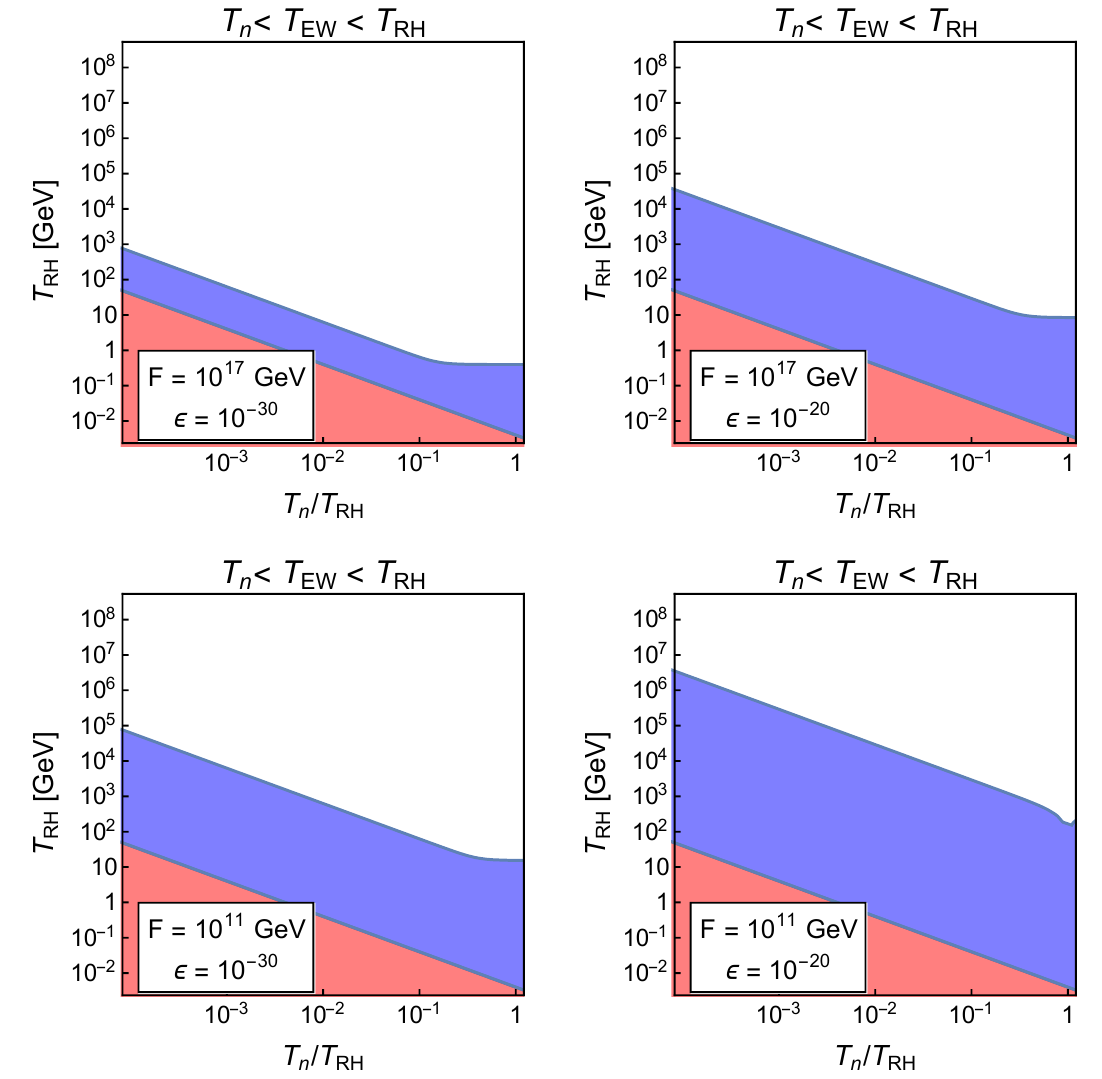
Figure 3. Regions in which the relative variation of the Higgs VEV of eq. (3.10) is larger than unity (blue) and therefore the solution of the hierarchy problem is spoiled and in which the nucleation or the reheating temperatures are smaller than 4 MeV (red). We suppose the initial VEV to be v All the plots show the T case. See the text for more n < T EW < T RH